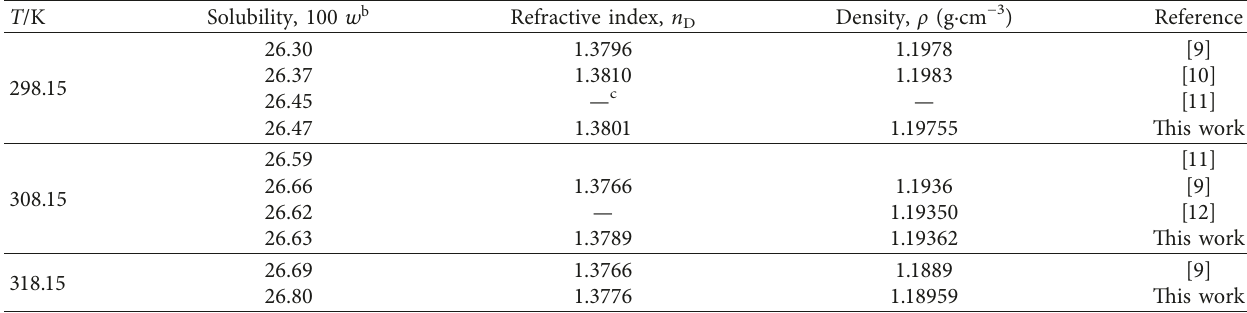
2 O) at 298.15, 308.15, and 318.15K and p